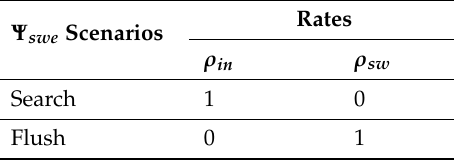
Table 3. SWE k Scenarios and token rates